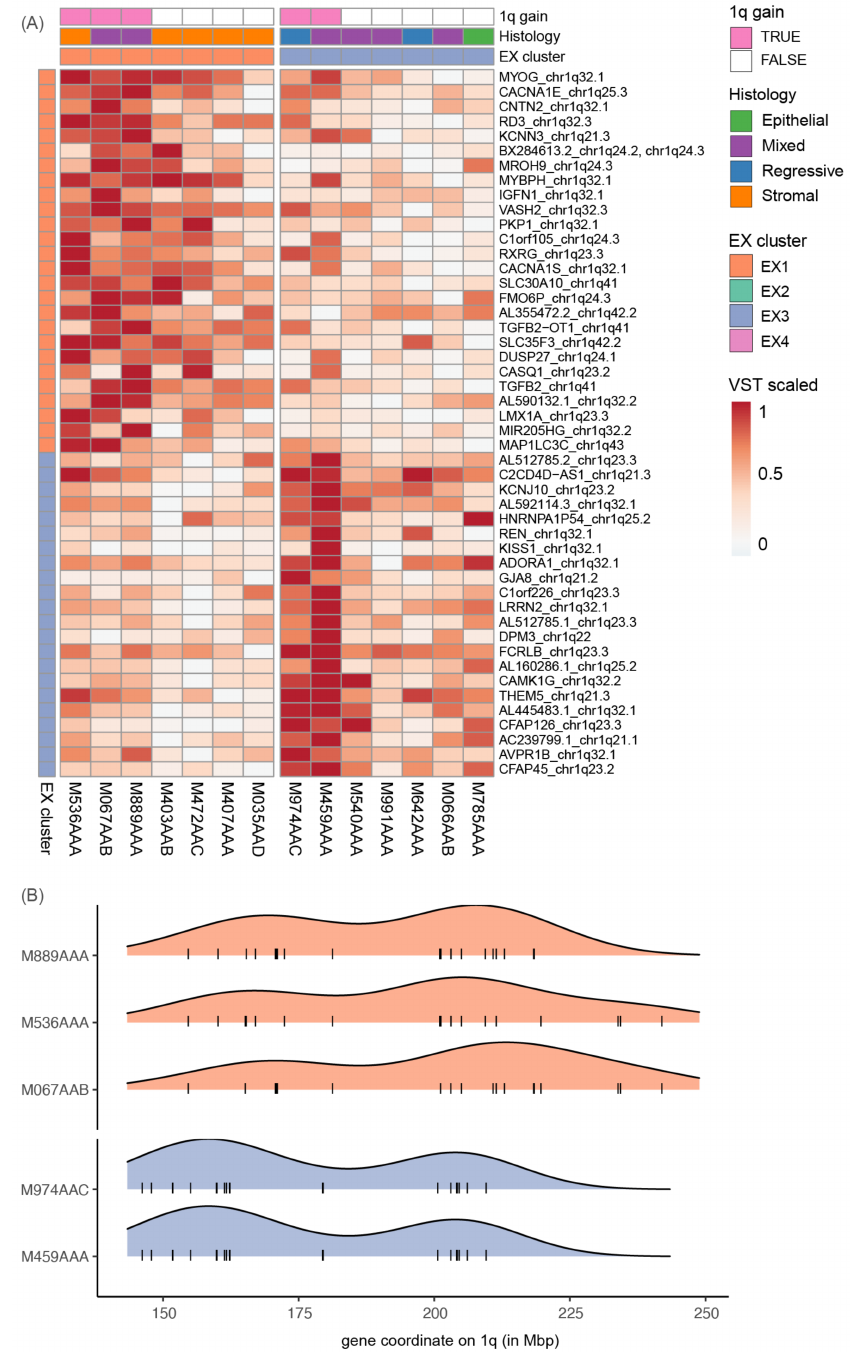
Figure 4. Wilms tumors with a 1q gain upregulate distinct gene sets. 1q+ tumors of EX1 and EX3 upregulate distinct gene sets corresponding to their expression cluster. Of the 51 genes recurrently upregulated (nz-score > 1.5) and recurrently altered by CNs/SVs within an expression cluster, 48 are located on 1q and assigned to either the EX1 ( n = 26 genes) or EX3 ( n = 22 genes) expression profiles. The EX2 and EX4 expression profiles did not contain genes located on 1q so therefore the tumors of EX2/EX4 are not shown. ( A ) The 1q+ tumors of EX1 upregulate genes assigned to expression profile EX1 (orange), and vice versa for 1q+ tumors of EX3 (blue). Expression values are scaled per row to highlight relative differences among tumors (columns) rather than between genes (rows). Tumors are annotated by their 1q gain status, histological subtype and expression cluster membership. ( B ) The 48 recurrently gained and upregulated genes (black lines) are distributed across the full 1q arm, and the density of these genes is similar for EX1 (orange) or EX3